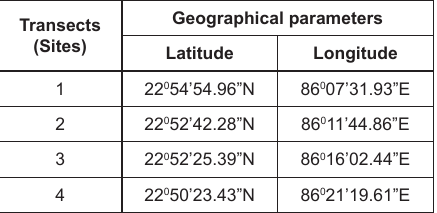
Table 1. Details of transects laid in the Dalma Wildlife Sanctuary, Jharkhand, India for bird sampling.